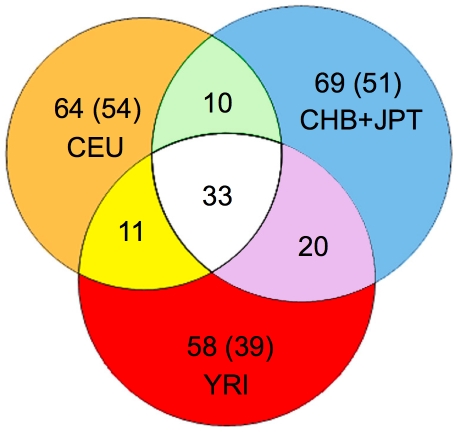
Analysis of the population distribution of bi-allelic OR loci reveals shared and population-specific CNVs.Venn diagram of 265 bi-allelic OR loci, which were distributed according to their recorded presence in the three populations analyzed (CEU, CHB+JPT, and YRI). Numbers in parentheses indicate OR loci in which a single copy-number genotype other than ‘2’ (indicating a CNV) was observed across 150 individuals; these loci may display rare, rather than population-specific CNVs.